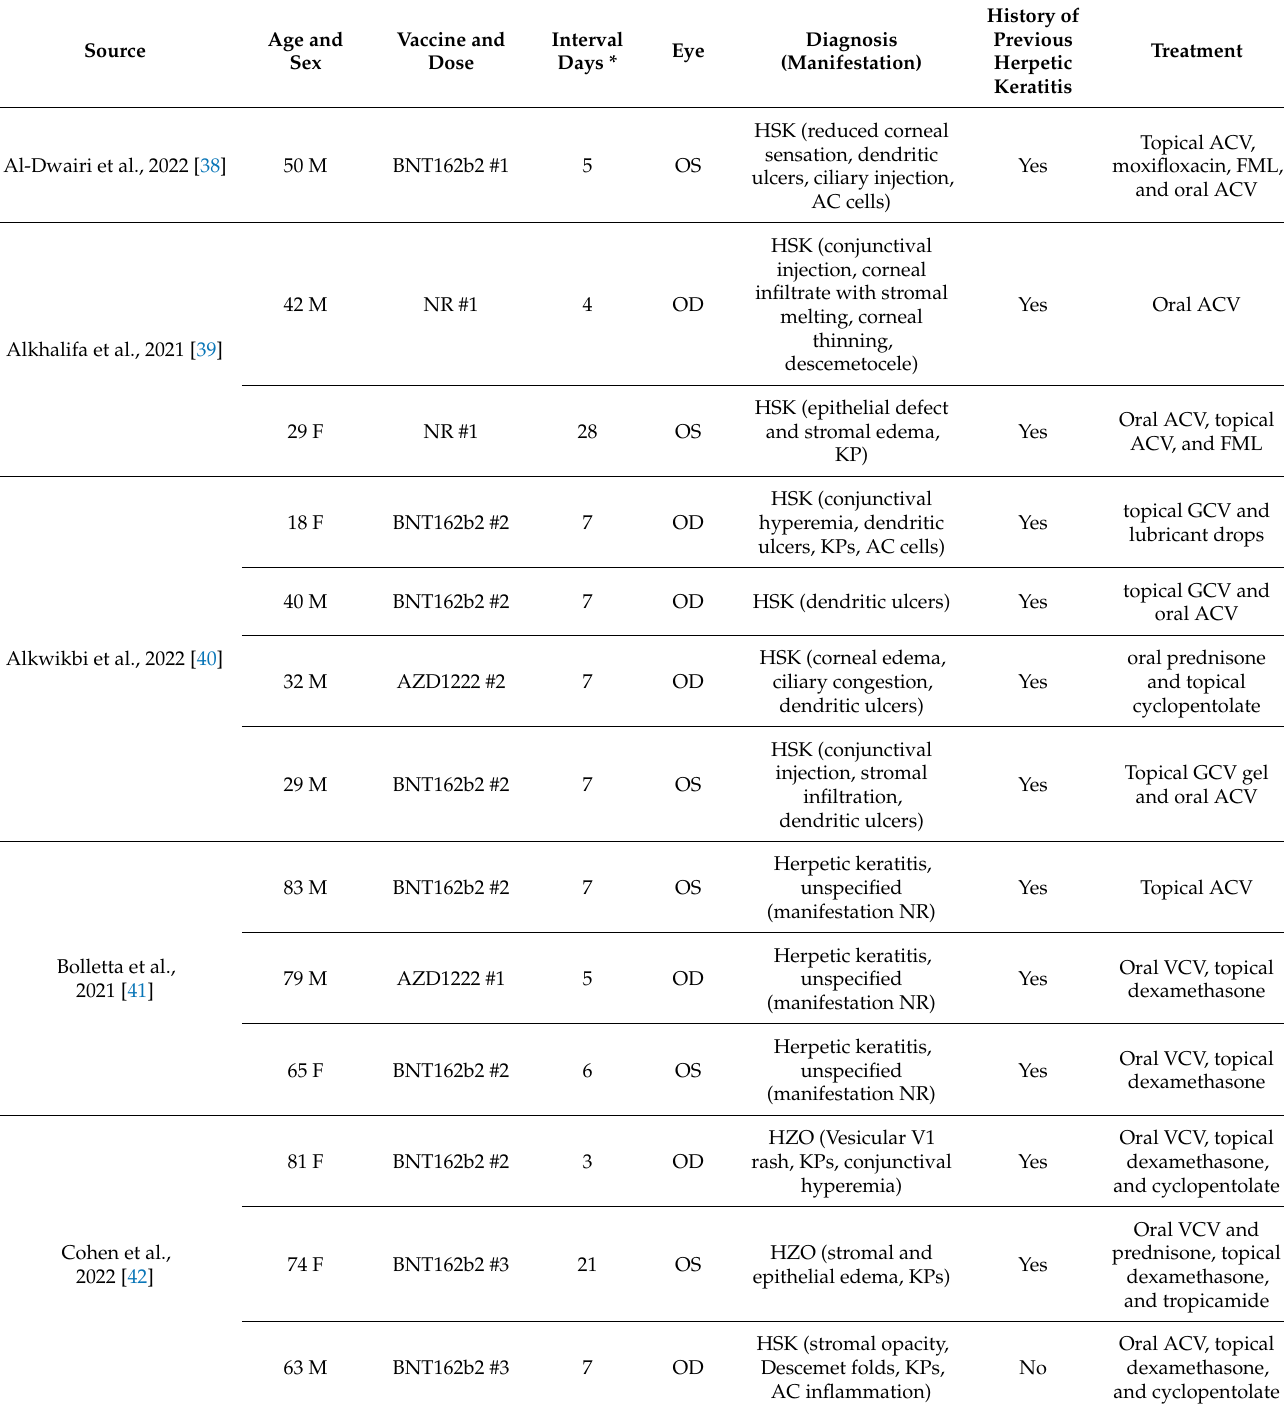
Table 2. Overview of reported cases of reactivation or recurrence of viral infections and initial herpetic